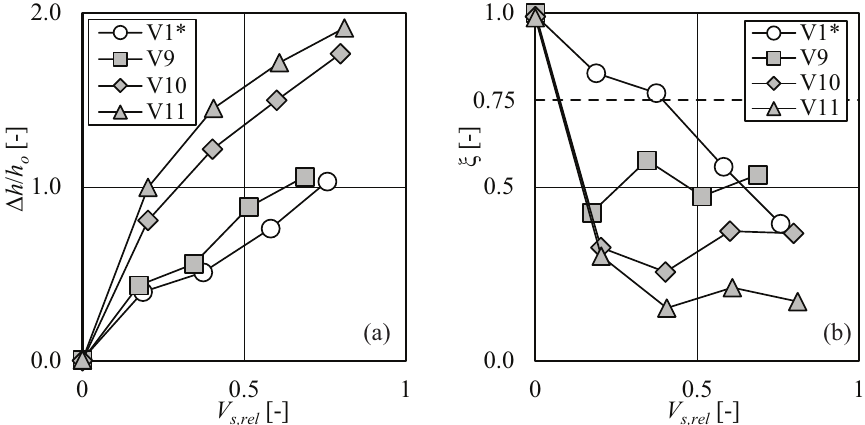
Figure 9. ( a ) Relative backwater rise ∆ h / h o and ( b ) bedload transport reduction factor ξ versus V s , rel for tests V1* (no FM ), V9 (10% FM ), V10 (30% FM ), and V11 (50% FM